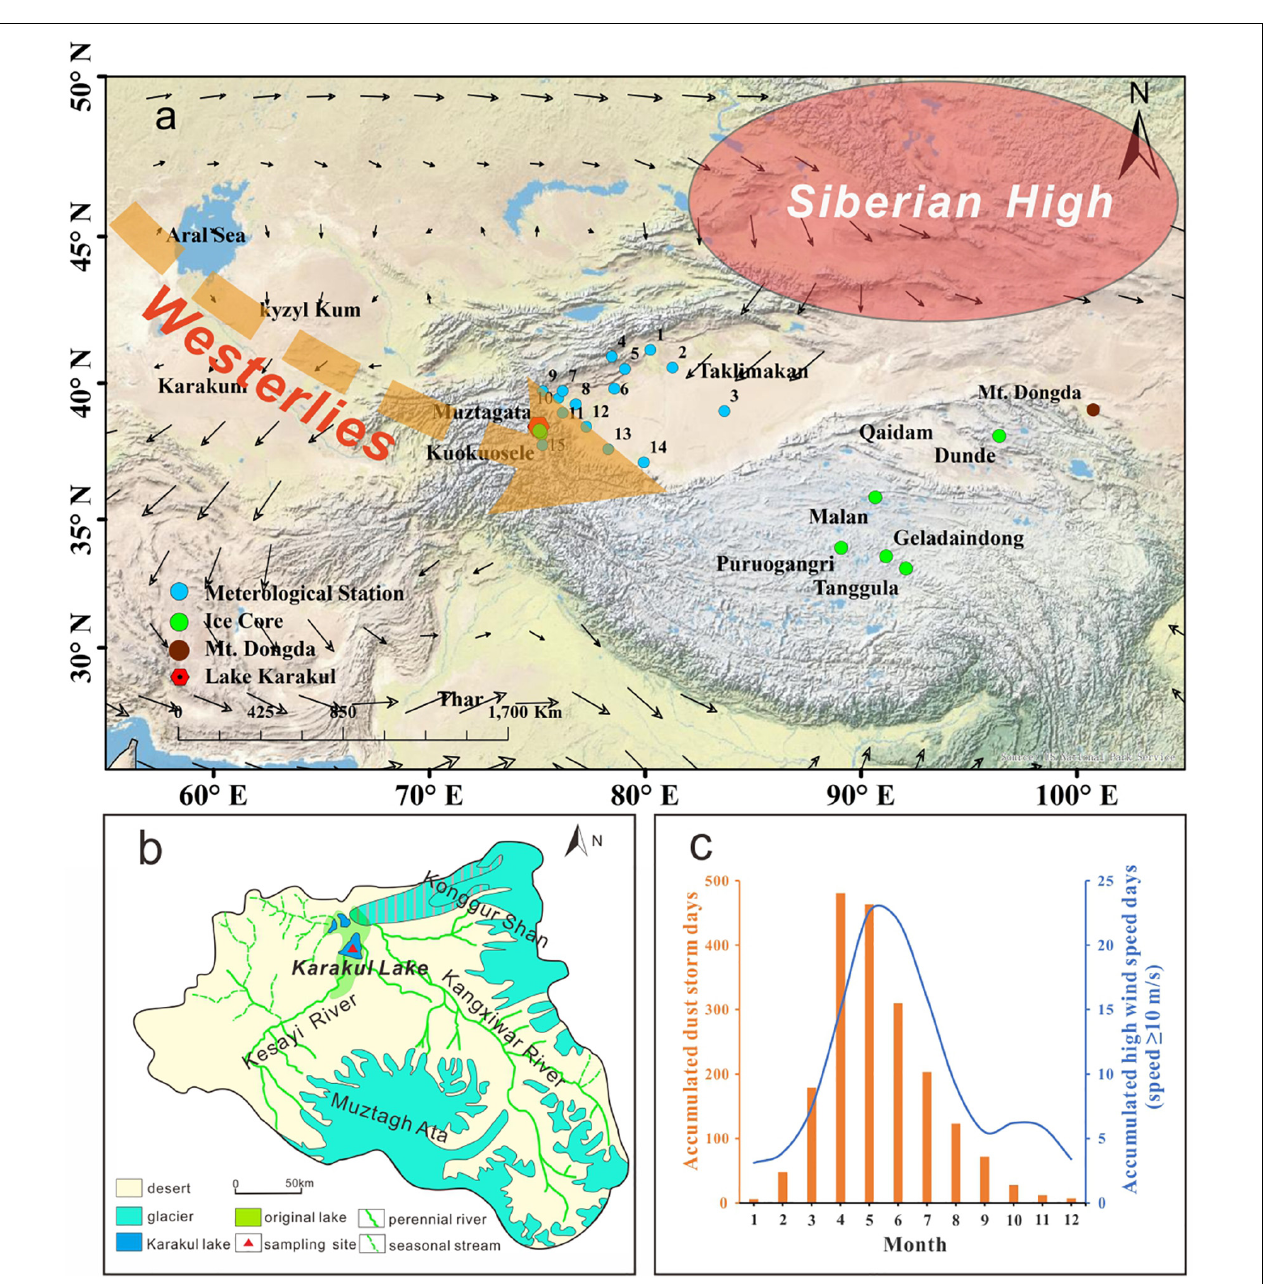
FIGURE 1 | Panel (a) Overview map showing the location of Lake Karakul (red hexagon) and ice core sites (green circles) and tree ring site (purple circle) mentioned in the text. Site numbers in panel a denote meteorological stations (blue circles; Supplementary Table S1 ). Arrows show wind field of April-June [850 hPa; 1979–2008 NCEP (National Centers for Environmental Prediction) reanalysis data]. Panel (b) shows the Lake Karakul catchment (redrawn from Yan et al., 2019), and the sampling site (red triangle). Panel (c) shows seasonal distribution of dust storm and high wind speed days (speed ≥ 10 m/s) in the central and western Tarim Basin. The dust storm days in panel (c) are the accumulated monthly dust storm days of 9 stations during 1960–2005 AD ( Supplementary Table S1 ); and the accumulated high wind speed days are the monthly high wind speed days of 5 stations during 1981–2010 AD ( Supplementary Table S1 ).